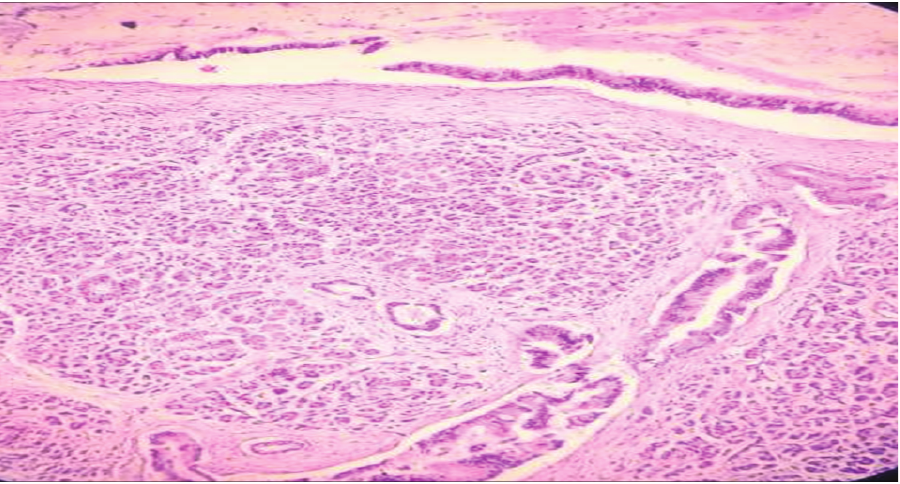
Figure 4 : Vascular invasion in carcinoma of pancreas H&E stain × 40.